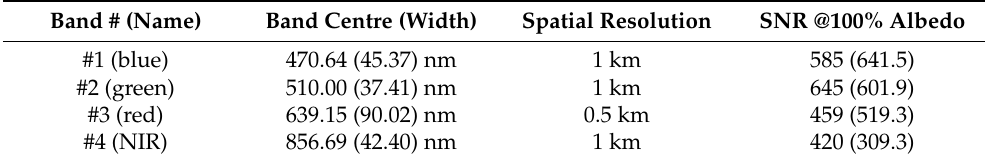
Table 1. Himawari-8 Advanced Himawari Imager visible and near-infrared bands central wave- Table 1. Himawari ‐ 8 Advanced Himawari Imager visible and near ‐ infrared bands central wave ‐ lengths and bandwidth, associated spatial resolution. Signal-to-noise ratios (SNR) from performance lengths and bandwidth, associated spatial resolution. Signal ‐ to ‐ noise ratios (SNR) from perfor ‐ test results [25]. mance test results [25].